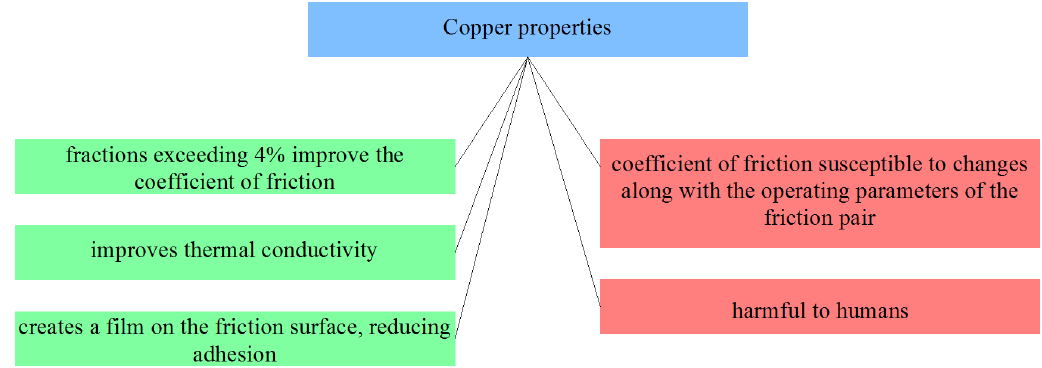
Figure 21: Selected copper composites properties from the point of view of applicability in friction materials